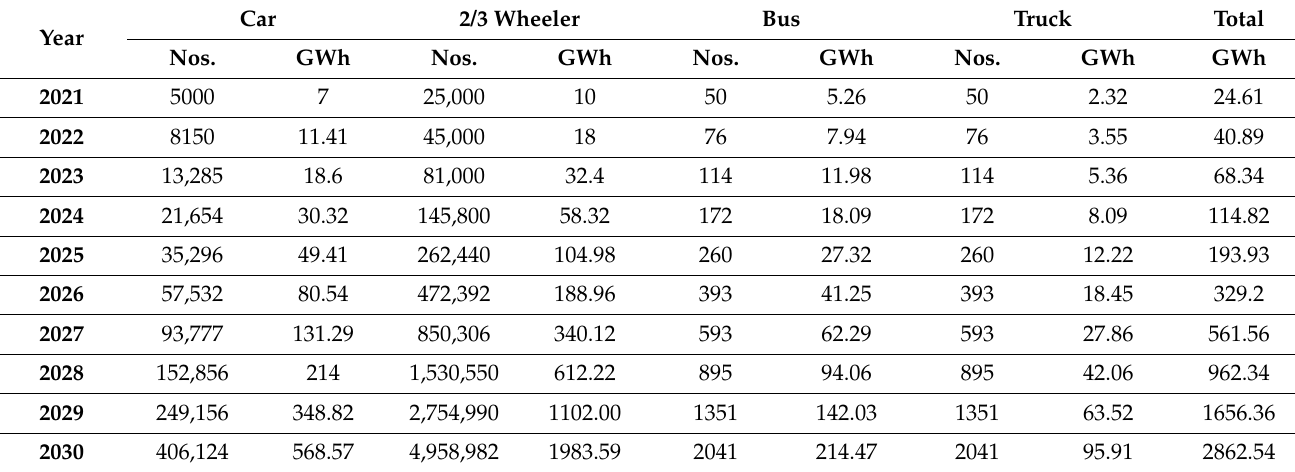
Table 6. Revised EV electricity consumption: